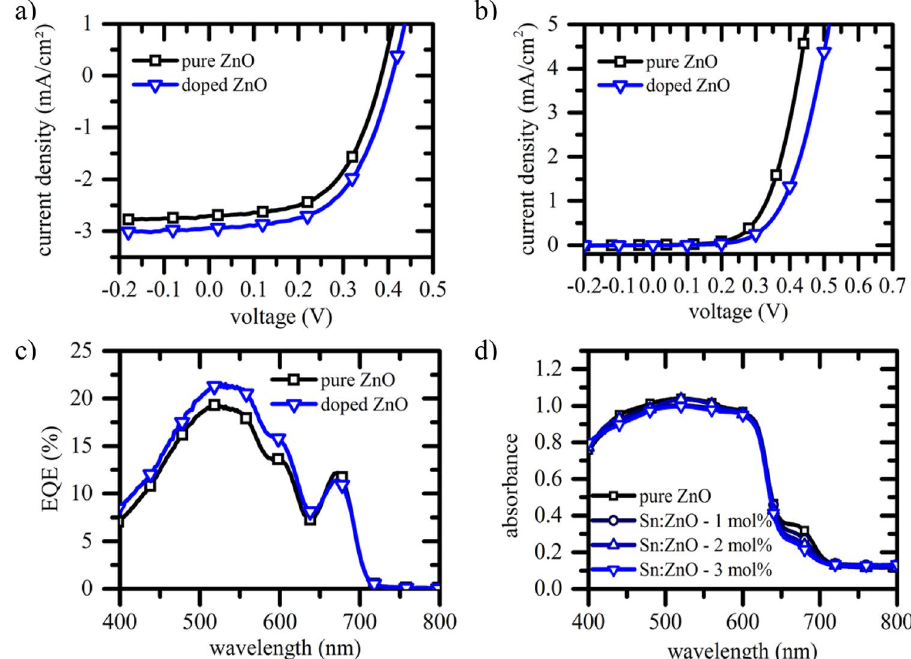
Figure 2. ( a ) J − V characteristics of hybrid solar cell under illumination using ZnO nanowire arrays with 3 mol% Sn 4 + doping (blue curve) and without doping (black curve) (AM 1.5G, illumination 100 mWcm-2); ( b ) J-V characteristics of the full device in dark. ( c ) EQE spectra of hybrid nanostructured devices; ( d ) absorption spectrum of the full structure for the pure and doped ZnO nanowire systems after decoration with SQ2-P3HT and evaporation of Ag.